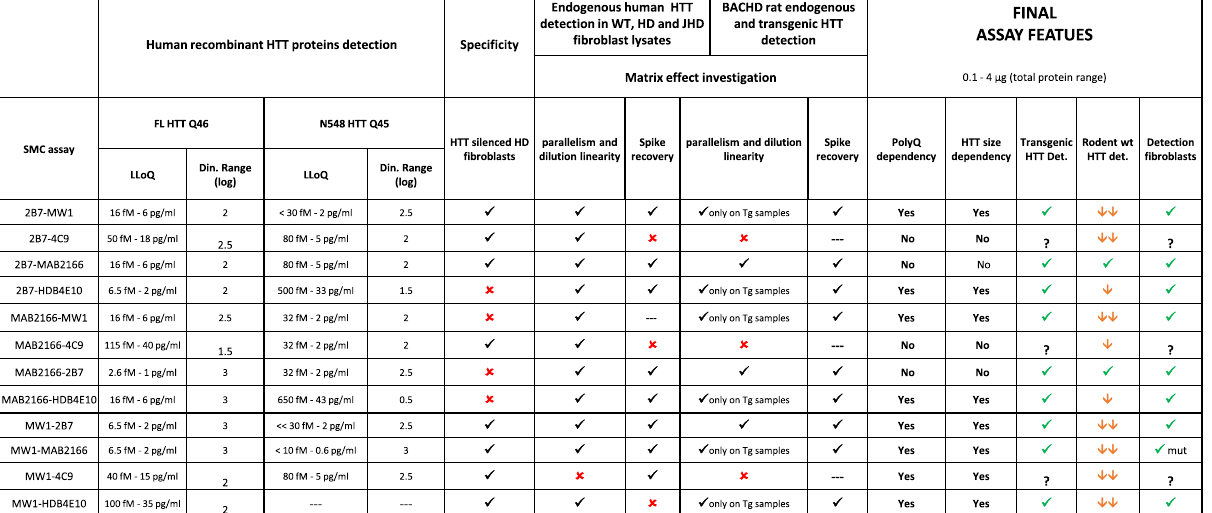
Table 1. Summary of all tests carried out for each antibody pair (first column). The symbols in the table are used as follows: “---”: the test was not carried out, green “ ✔ ”: the test successfully passed, red “ ✘ ”: the test did not passed, “?”: impossible to call, “ ↓ ”: low detection, “ ⇊ ”: very low detection. Additional abbreviations are: WT (wild type), HD (Huntington’s disease primary samples), JHD (juvenile Huntington’s disease primary samples), Tg (transgenic), mut (mutant